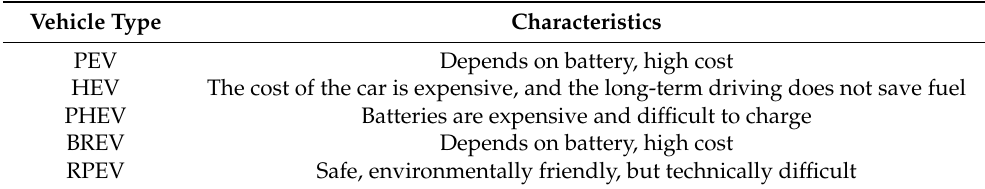
Table 1. The characteristics of different